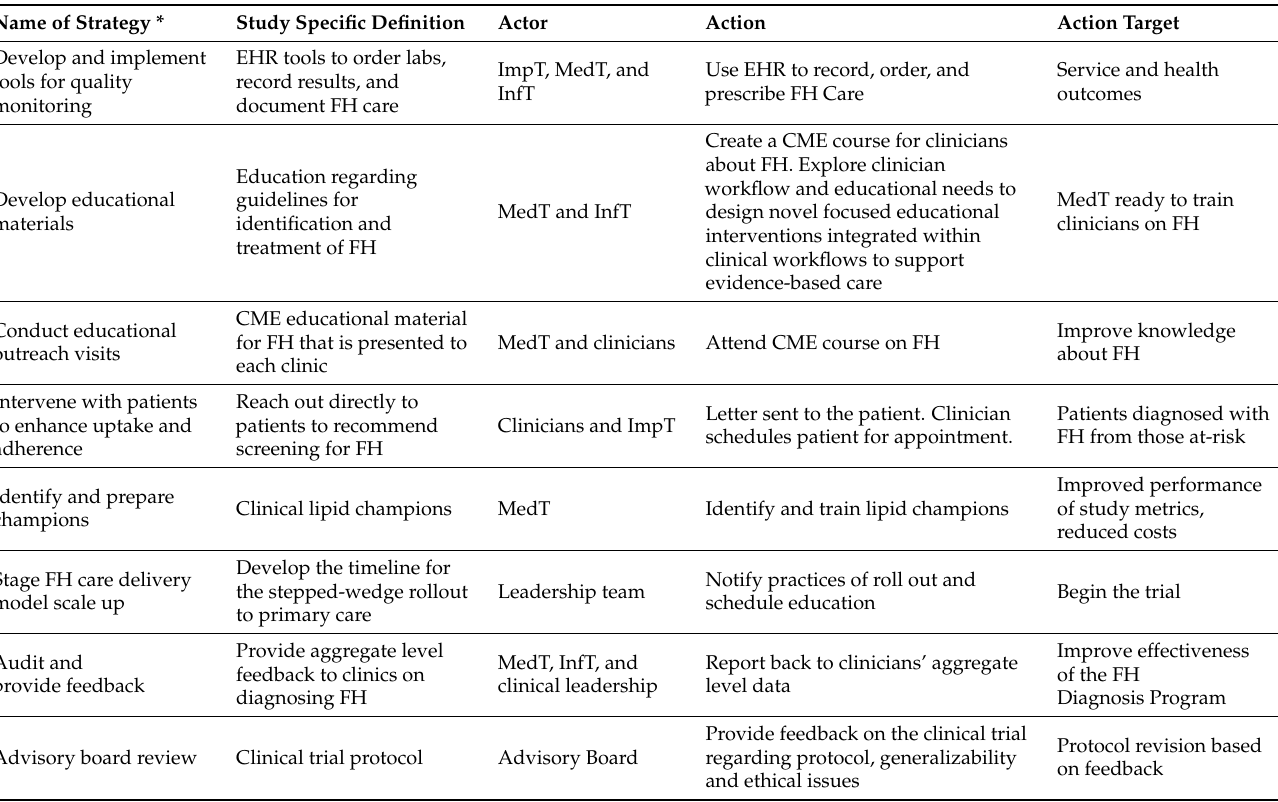
Table 1. Potential implementation strategy